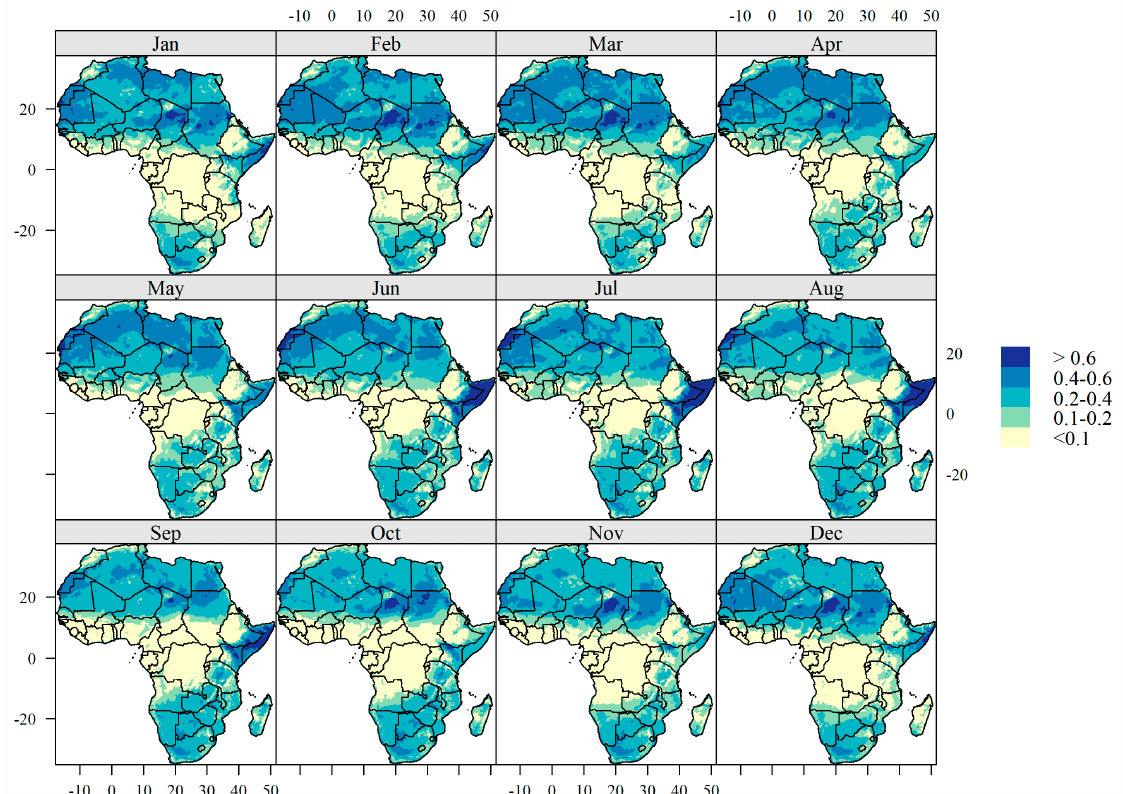
Figure 2. The monthly mean wind power potential in terms of CF over the 2000–2017 period. Figure 3 presents the minimum and maximum values of CFM across the continent, and the corresponding month in which these two values are realized in each location. In Central and Western Africa, Ethiopia, and some local spots (e.g., in local sites in Morocco, Northern Algeria, Angola), the maximum mean monthly CFM values are quite low (close to zero in most parts). In these areas, the wind power potential is low all the